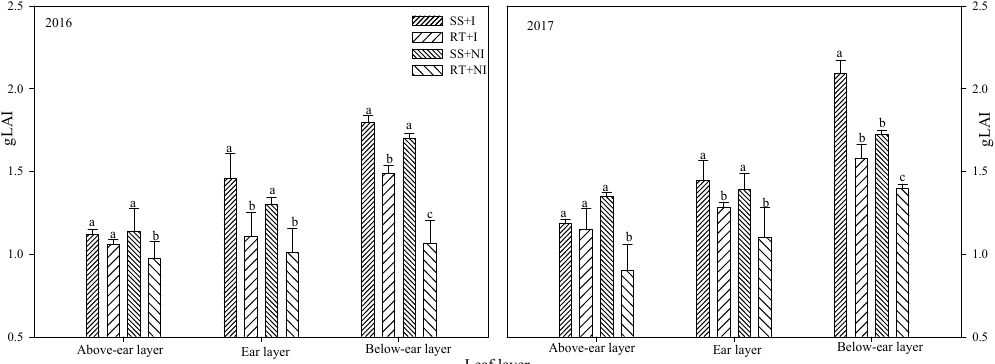
Figure 2. Effects of different tillage practices on the gLAI of different leaf layers in maize. Different Figure 2. E ff ects of di ff erent tillage practices on the gLAI of di ff erent leaf layers in maize. Di ff erent small letters under the same leaf layer indicate significant differences between tillage practices. small letters under the same leaf layer indicate significant di ff erences between tillage